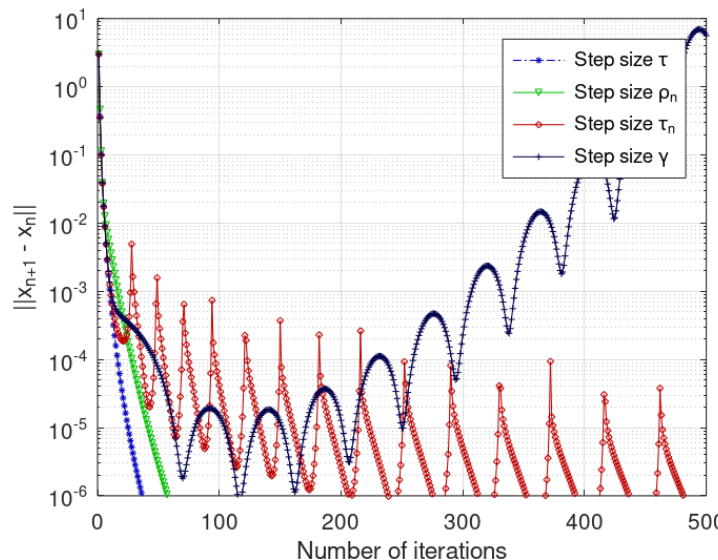
Figure 4. Comparison of (cid:107) x n + 1 − x n (cid:107) with different step sizes. Table 2. Comparison table of Figures 3 and